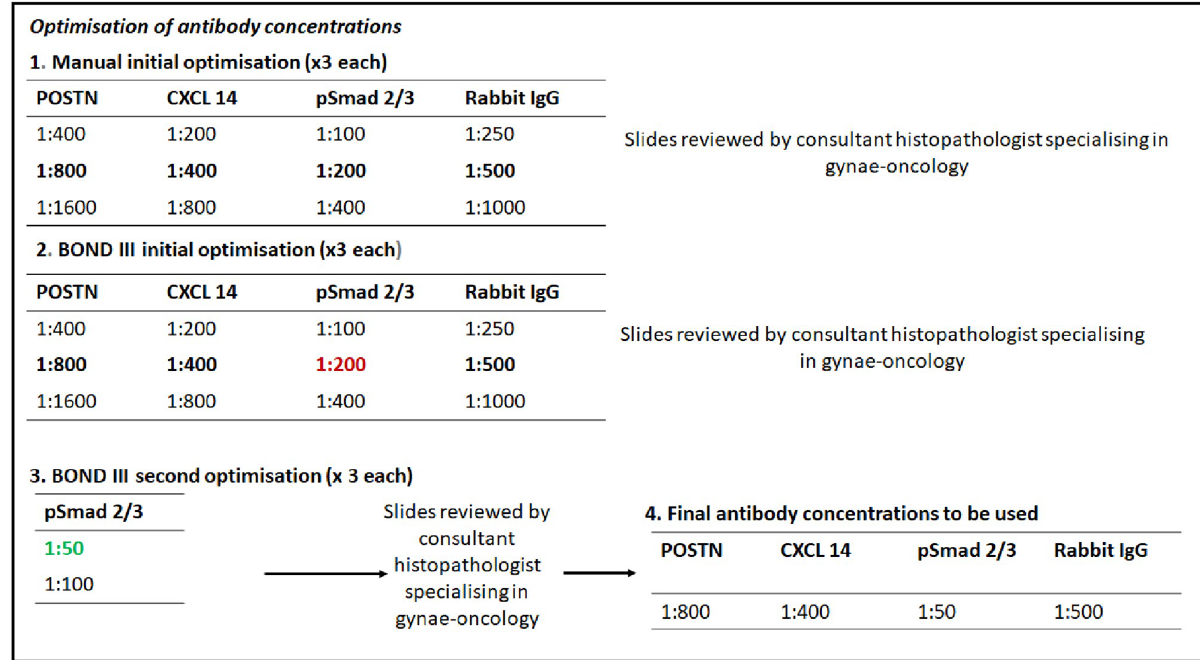
Fig 2. Optimisation process for antibody selection. Step one shows in bold antibody dilutionsused in original study. Three slides per dilution were stained for concentrations more and less dilute than the original. Following hand staining, stained slides were reviewed by the author and a consultant histopatologist with a specialty in gynae oncology, to ensure adequate staining. Step two again describes the range of dilutions stained on the automated platform. Review agreed adequate staining for POSTN and CXCL 14, however psMAD 2/3 appeared under-stained at dilutions used in the original paper. For this reason a further optimisation step was performed and a dilution of 1:50 was then agreed to result in adequate staining. Step four highlights antibody concentrations used in final IHC of whole validation cohort.